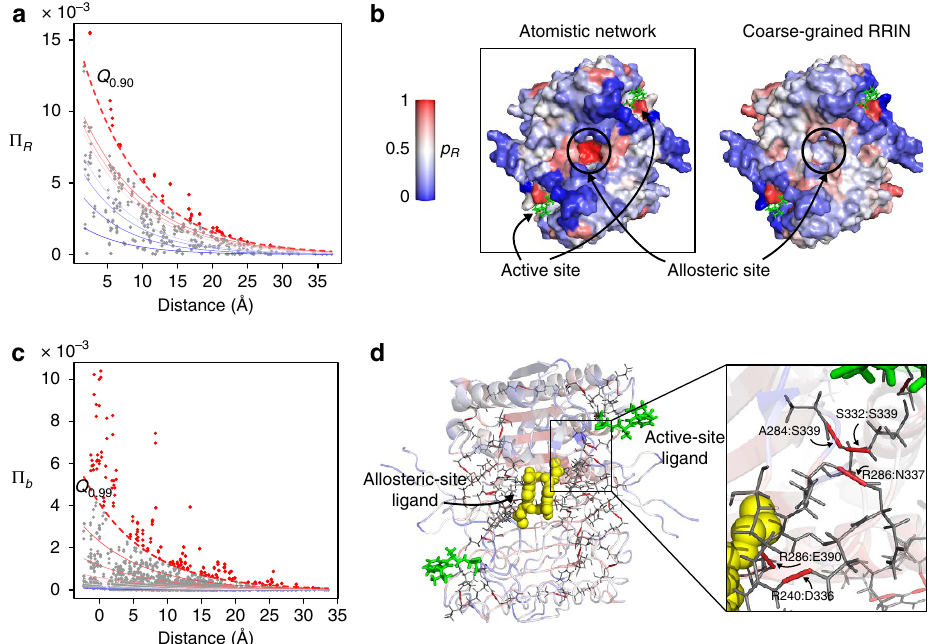
Figure 1 | Bond-to-bond propensities identify the allosteric site and atomistic pathway in caspase-1. ( a ) The propensities of all residues P R are plotted against their distance from the active site. The lines correspond to the quantile regression estimates for the p -th quantiles Q p , with p ¼ 0.1,0.2, y ,0.8,0.9. The dashed red line indicates the Q 0.90 cutoff used for identifying important residues. ( b ) The quantile scores p R for each residue are mapped onto the surface of caspase-1. The active-site ligand is shown in green. The allosteric binding site is identified as a hotspot of high propensity. When a coarse-grained RRIN with cutoff of 6Å is used (right), the allosteric binding site is not identified. ( c ) The propensities of bonds P b are plotted against their distance from the active site with the Q 0.99 quantile indicated by the dashed line. ( d ) High quantile score bonds ( p b Z 0.99) are shown on the structure. Bonds between R286:E390, R240:D336, R286:N337, A284:S332 and S332:S339 have large quantile scores and form contiguous pathways between the active and allosteric sites. The active-site ligand is shown in green and the allosteric ligand is shown as yellow